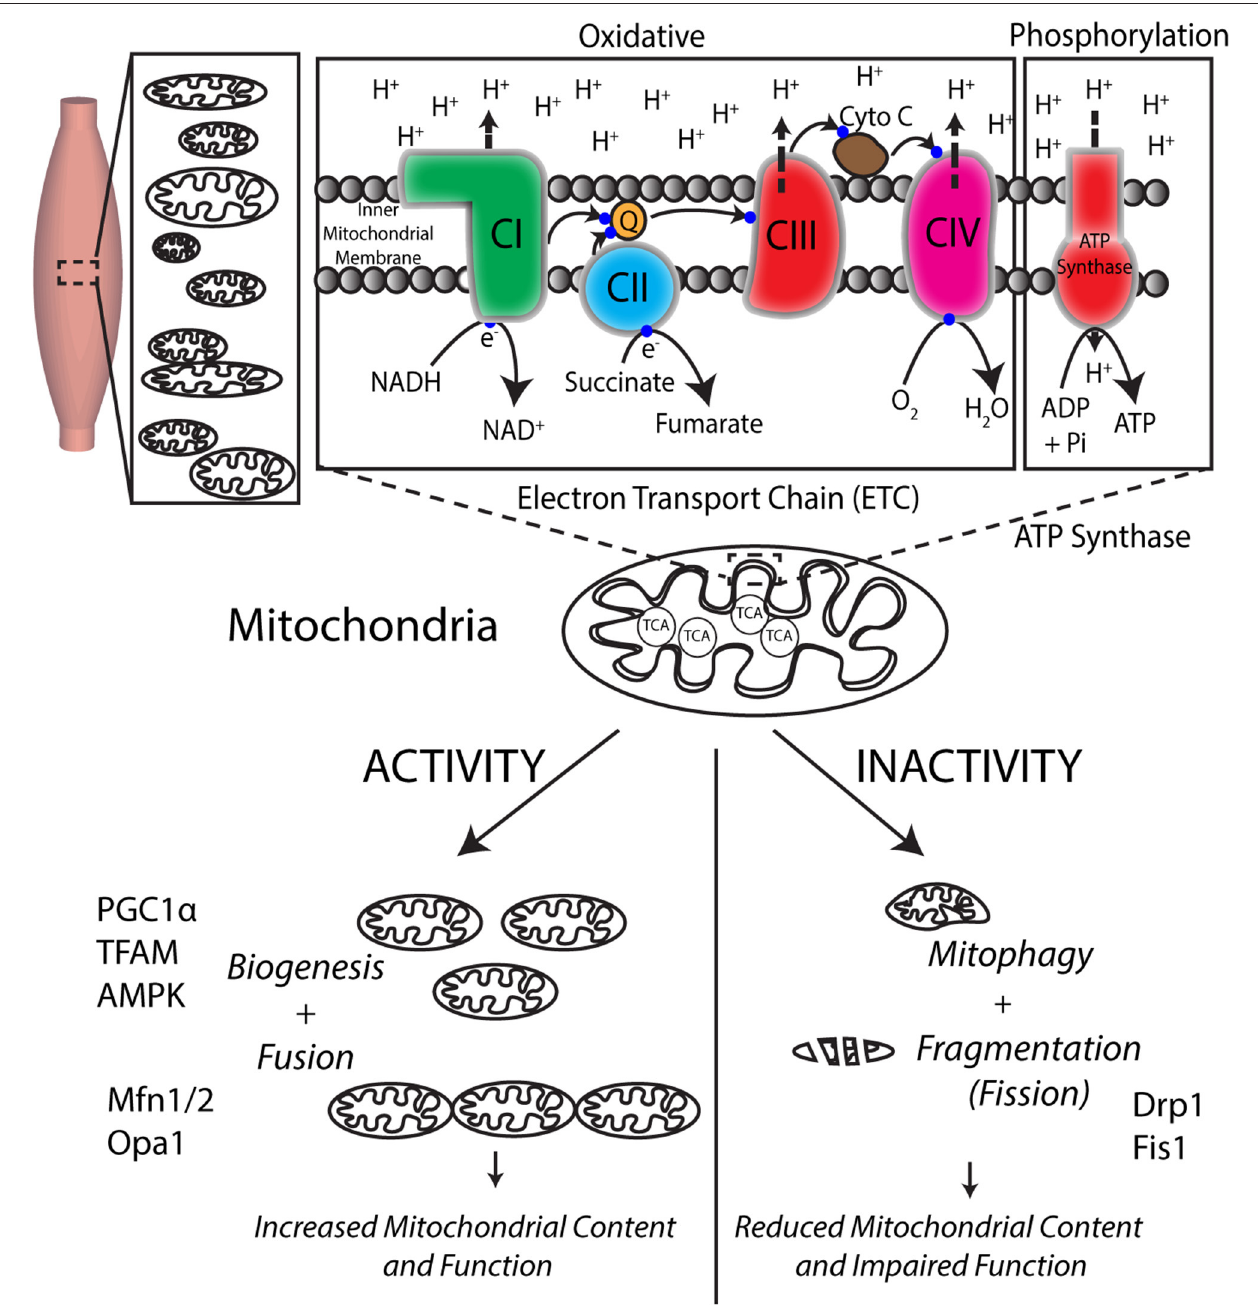
FIGURE 2 | Mitochondria are responsible for energy production via cellular respiration and are dynamically regulated by exercise. Skeletal muscles have numerous mitochondria for the production of energy required for force production. The TCA cycle within the mitochondria helps break down food to create substrates that feed into the numerous electron transport system (ETC) units located in the mitochondrial inner membrane. The flux of electrons through the four protein complexes of ETC uses the substrates coupled with oxygen utilization to create a proton (H + ) gradient across the inner mitochondrial membrane, which drives energy generation at the ATP synthase. Mitochondria respond positively to consistent exercise by creating new mitochondria by mitochondrial biogenesis, while inactivity negatively impacts their function and